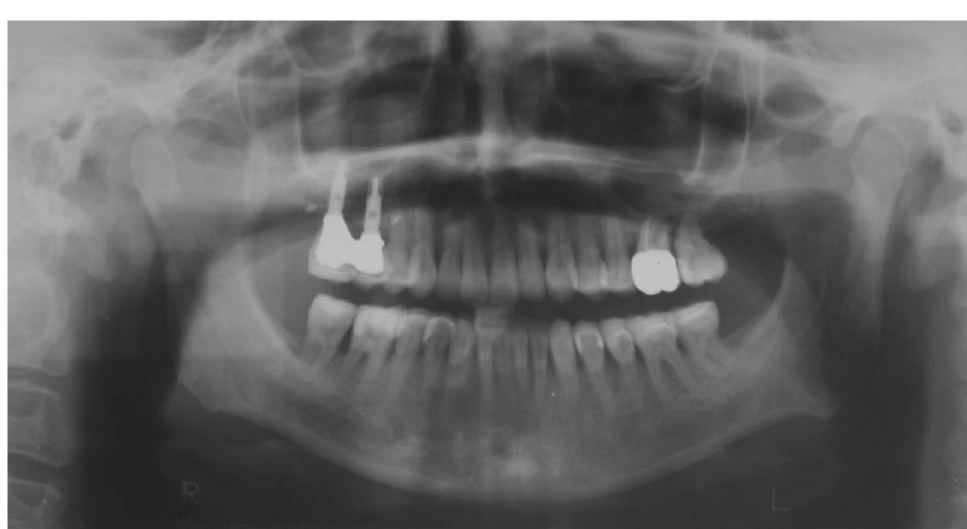
Figure 16. Orthopantomography at 24 months.